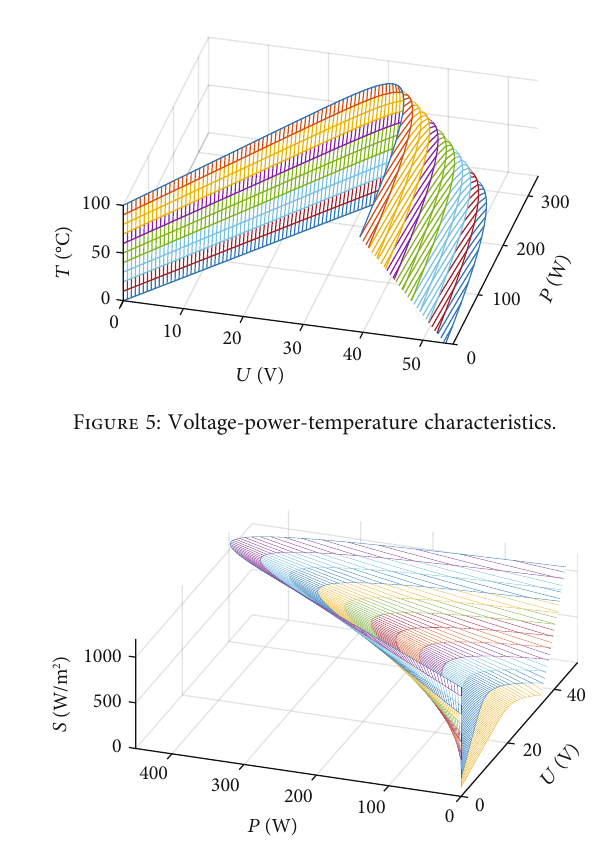
Figure 6: Voltage-power-solar irradiance characteristics.